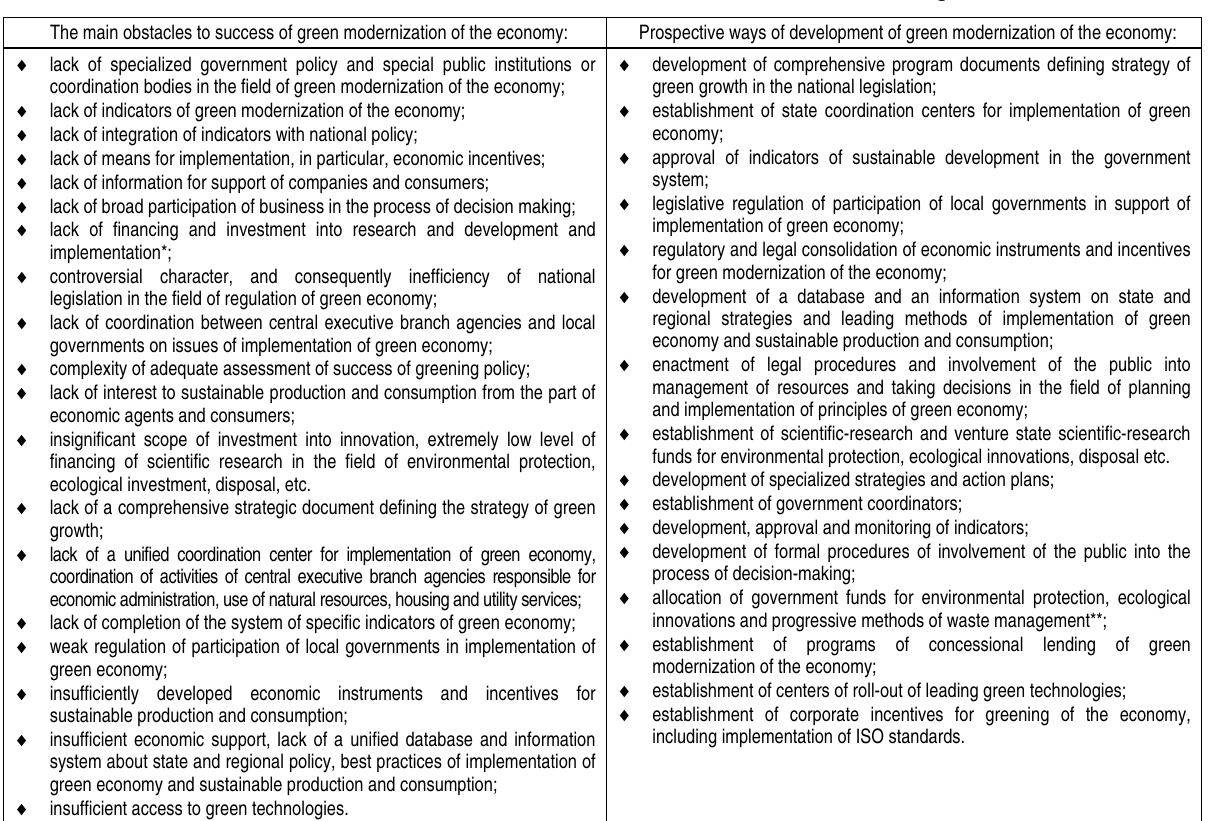
Table 1. The main obstacles to success and prospective ways of development of green modernization